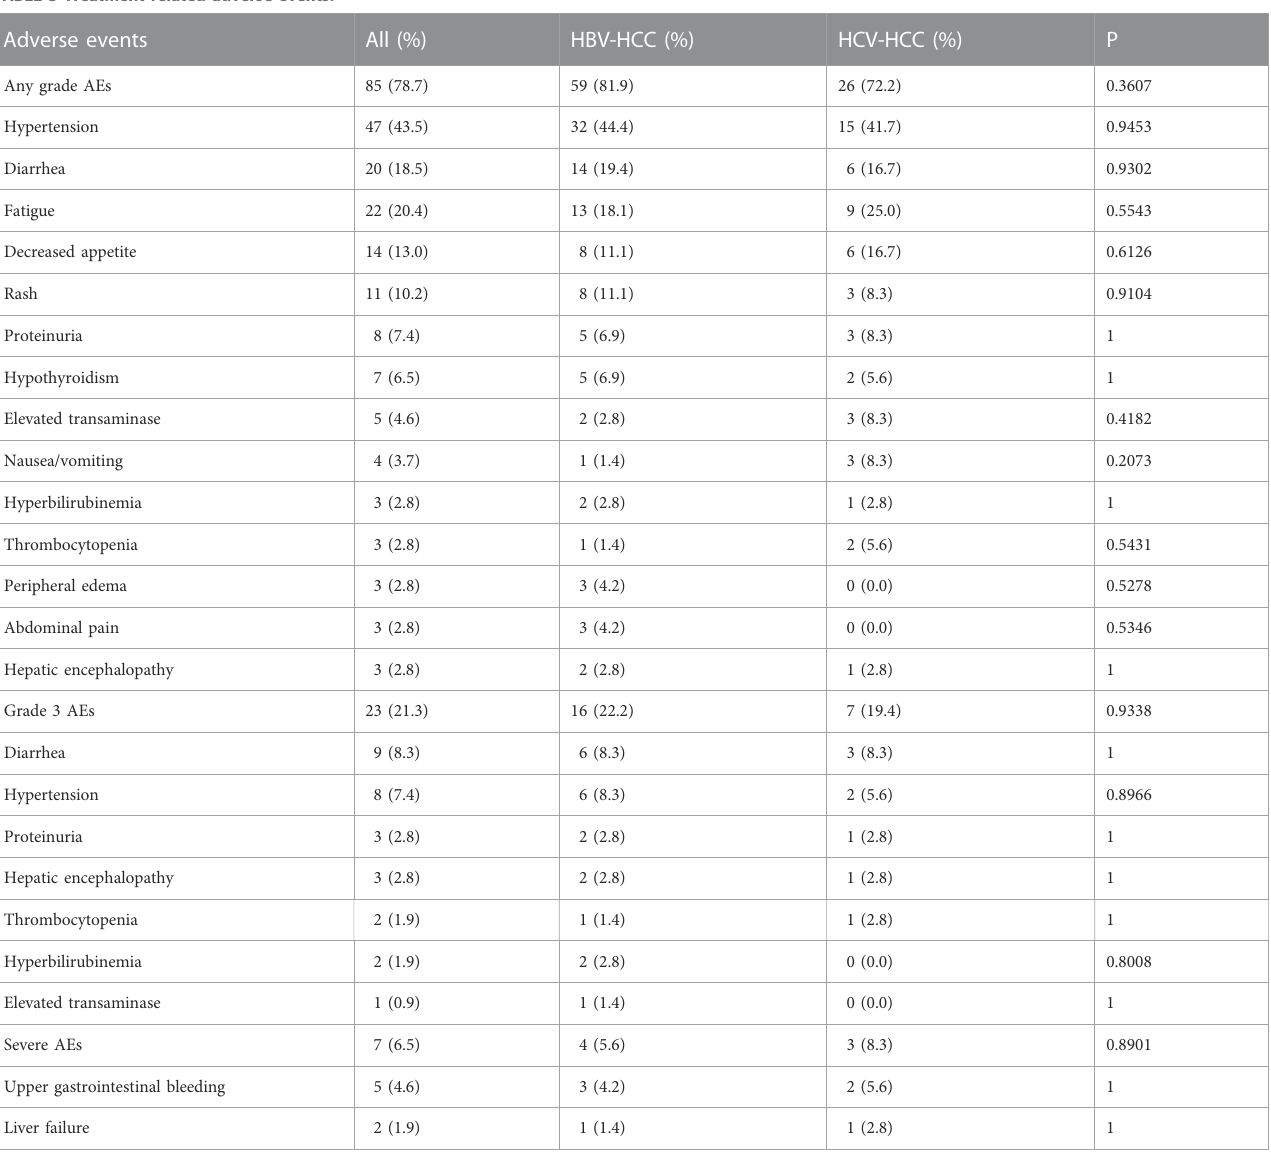
TABLE 3 Treatment related adverse